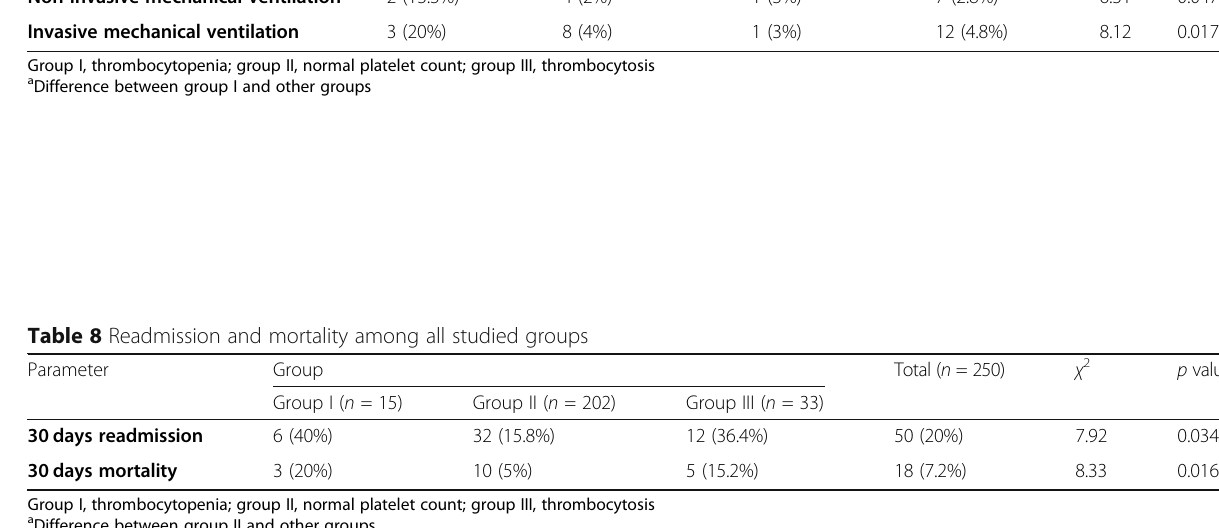
Table 7 Distribution of need for mechanical ventilation among all studied groups Parameter Group Total ( n = 250) Group I ( n = 15) Group II ( n = 202) Group III ( n = 33)